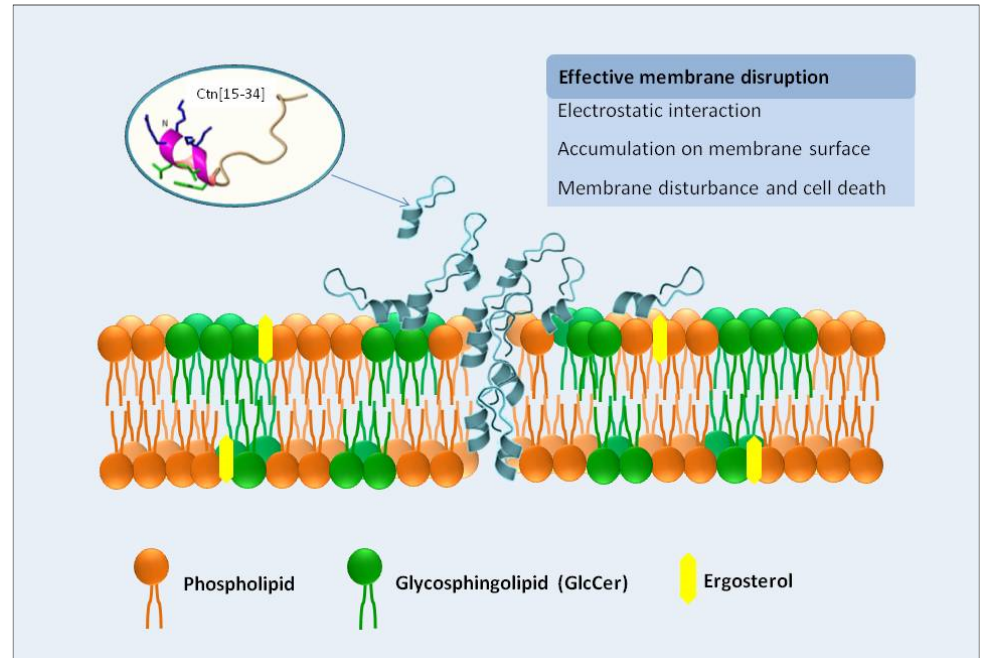
Figure 6. Depicted mechanism of action of Ctn[15–34] on the interaction and disruption of plasma membrane of the pathogenic yeast Candida albicans . The plasma membrane of yeast cells is the primary target of Ctn[15–34] actions, as demonstrated experimentally by biophysical methods. Ctn[15–34] is recruited to the plasma membrane, through a process facilitated by the electrostatic attraction between the cationic residues of the peptide and the anionic lipids present in the plasma membrane of planktonic yeast or yeast cells in biofilms. After accumulation on the cell surface, peptide can efficiently insert into the lipid bilayer, causing membrane destabilization, as observed by changes in membrane dipole potential, with consequent death of the C. albicans cells.